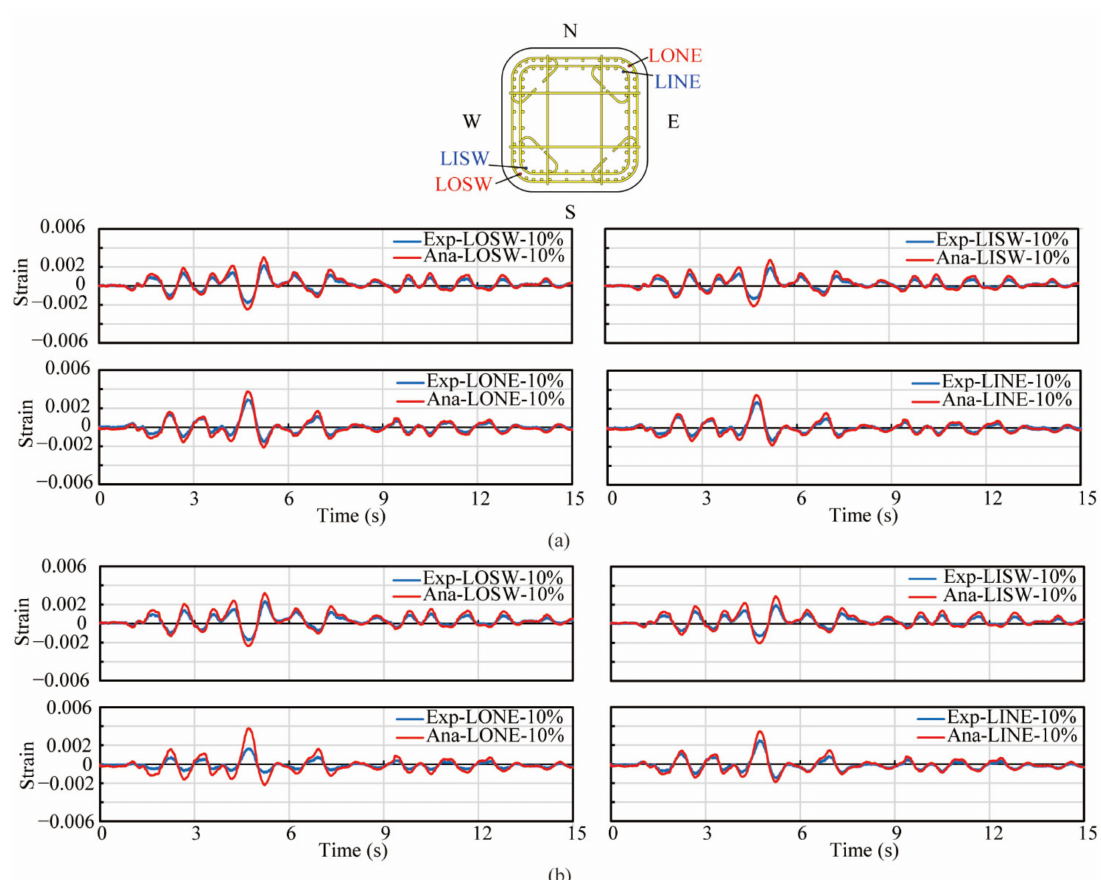
Figure 10. Correlation of strain in longitudinal reinforcements during the 1st excitation. ( a ) PFRC-1, ( b ) PFRC-2.